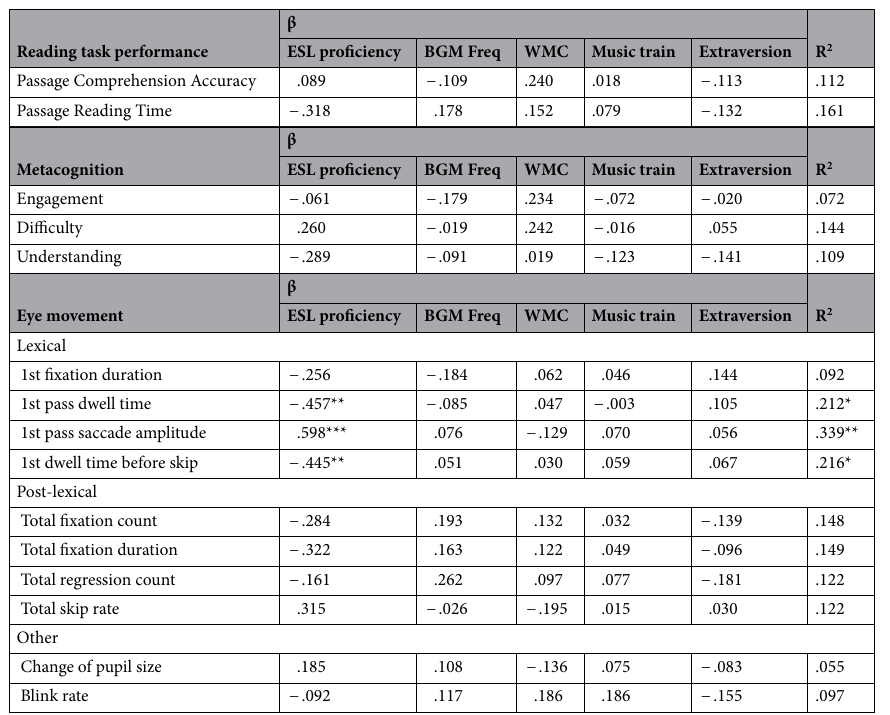
Table 7. Classical linear regression models of silence group (Control). Please refer to Note below Table 6 for abbreviation definition. * p < .05; ** p < .01; *** p <